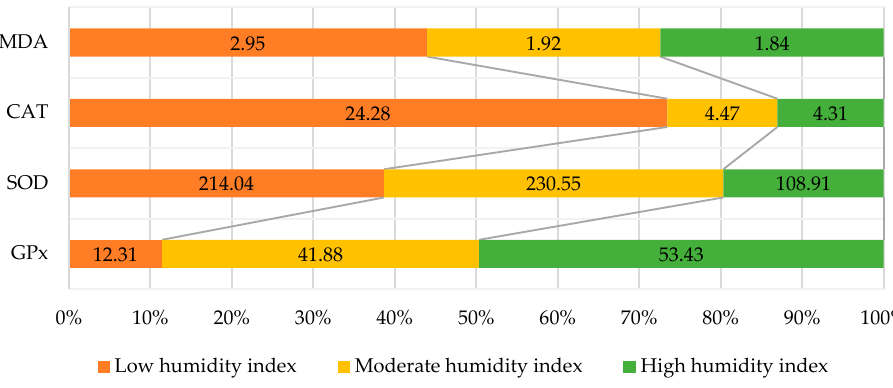
Figure 2. Effect of temperature–humidity index (THI) on antioxidant status of lactating cows.